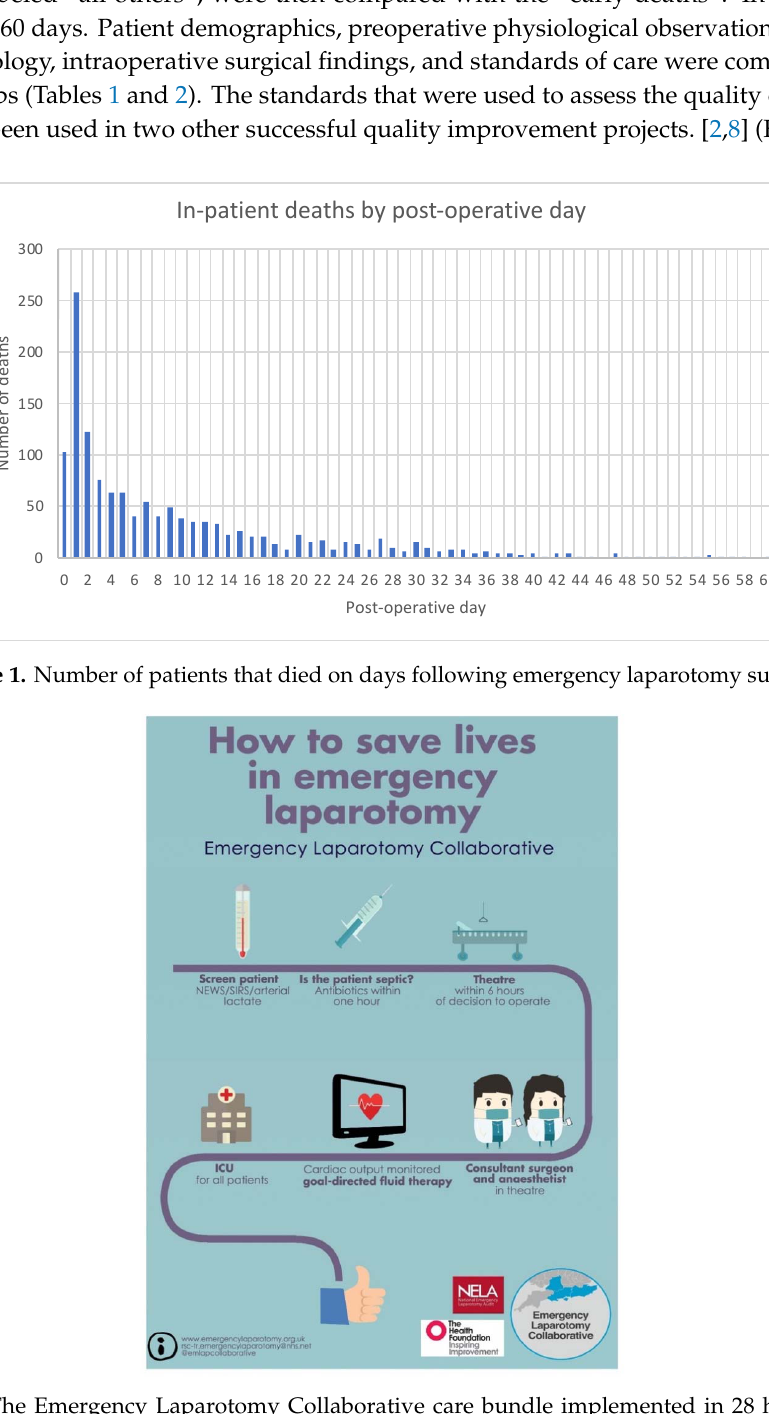
Figure 2. The Emergency Laparotomy Collaborative care bundle implemented in 28 hospitals in the South of England. ICU: intensive care unit, SIRS: systemic inflammatory response syndrome, NEWS: National Early Warning Score.